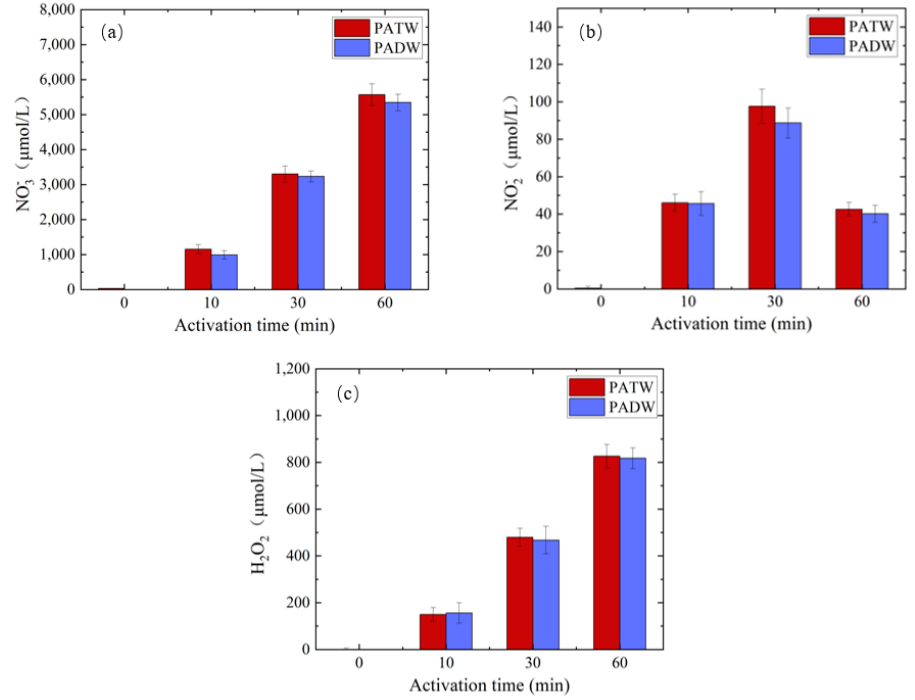
Figure 8. The concentration of aqueous RONS in PATW and PADW as a function of activation time. ( a ) NO 3− , ( b ) NO 2− , ( c ) H 2 O 2 .